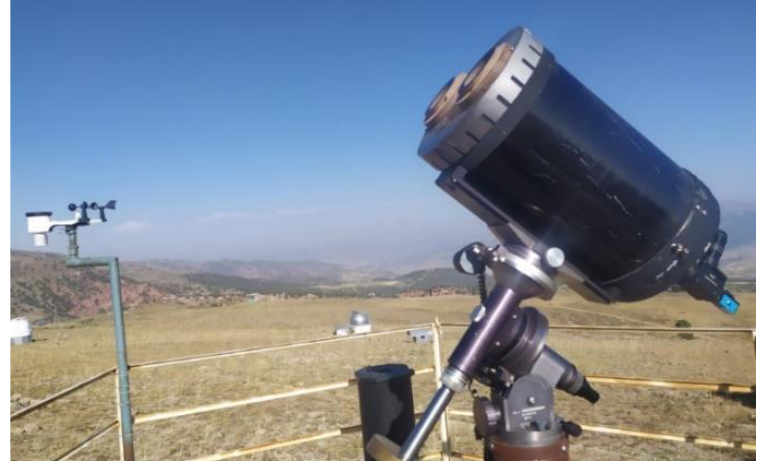
Figure 3. DIMM equipment and weather station.